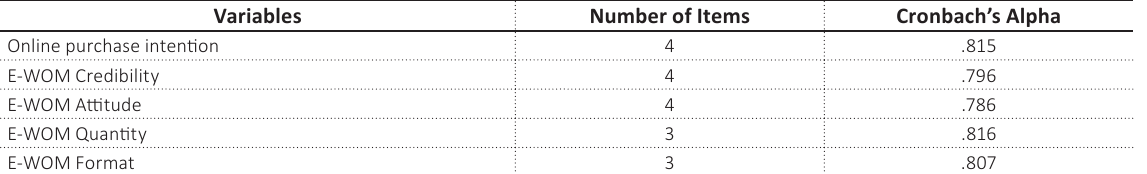
Table 4. Cronbach’s alpha